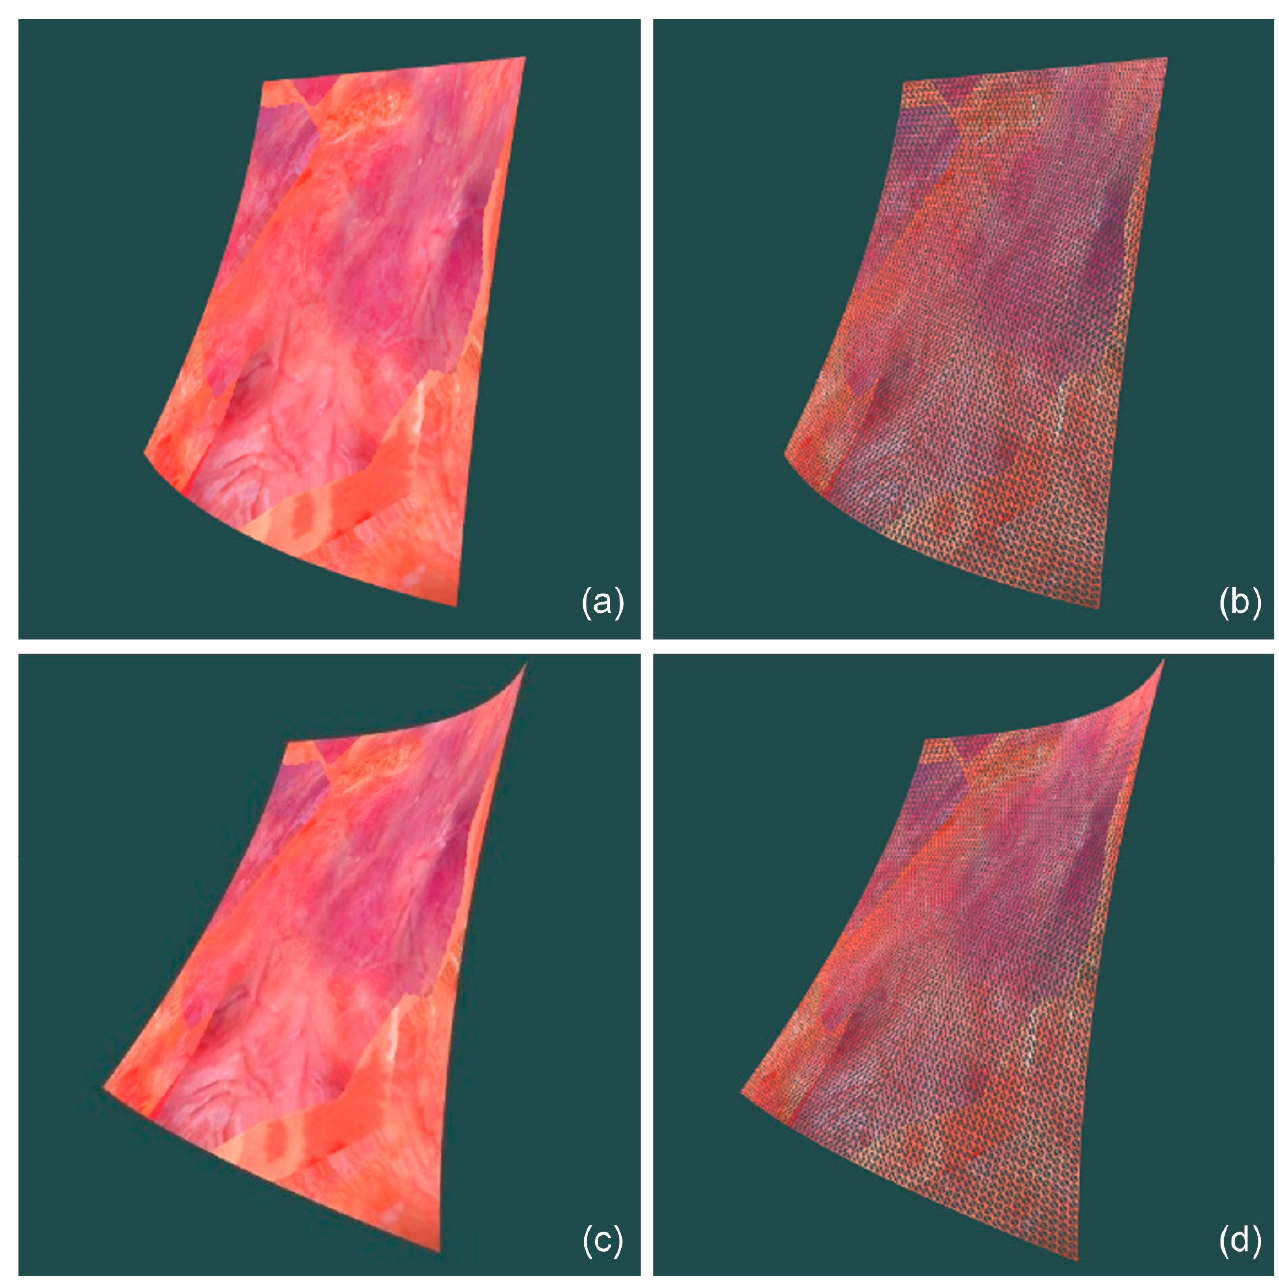
Figure 8. Comparison of the model effects between two frames before and after: ( a ) side view model effect of the first frame, ( b ) side view model effect of the second frame, ( c ) effect of the viewpoint model on the first frame side, and ( d ) effect of the viewpoint model on the second frame side.